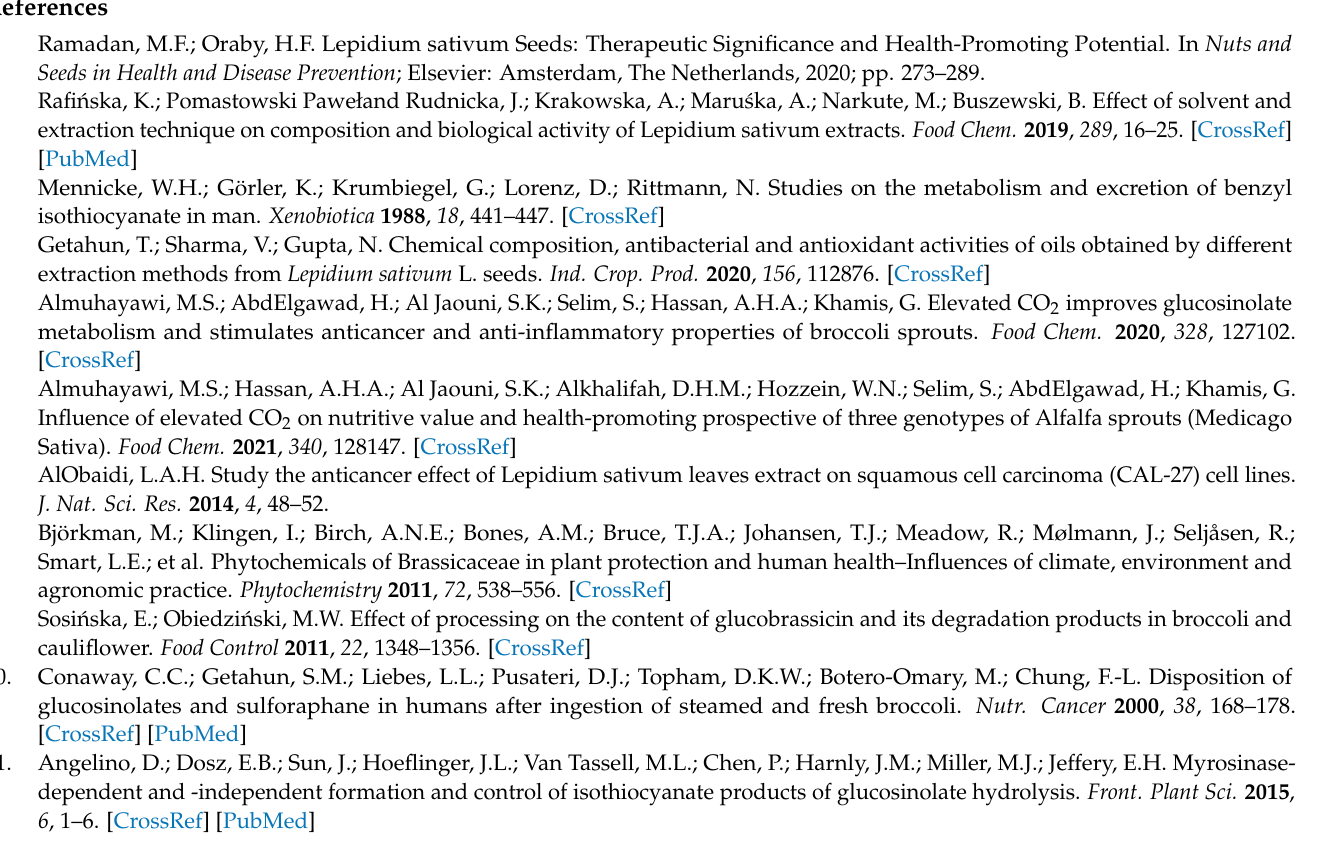
their interaction on the assessed parameters in L. sativum sprouts, Table S2: Levels of antioxidant metabolites, glucosinolates, their amino acid precursors and activities of phenylalanine ammonia lyase and myrosinase in the sprouts of three L. sativum cultivars grown under either aCO2 or eCO2, Table S3: Antioxidant, anti-inflammatory, hypocholesterolemic, anti-cancer and antibacterial activities of the sprouts of three Lepidium sativum cultivars grown under either aCO2 or